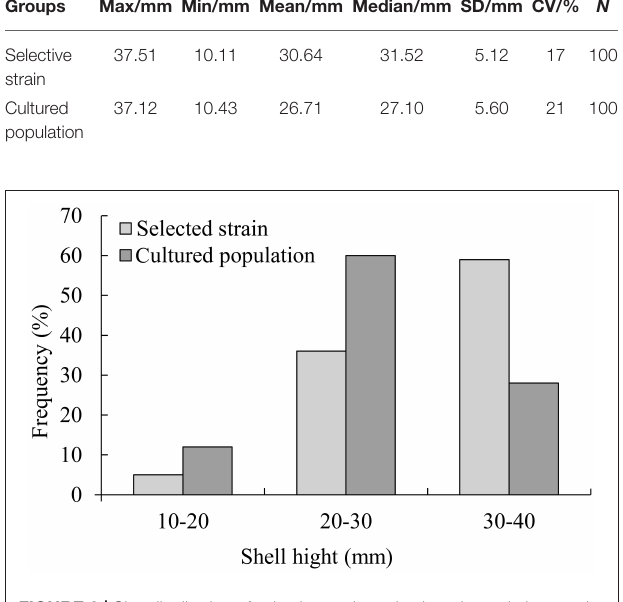
FIGURE 2 | Size distribution of selective strain and cultured population pearl oysters at